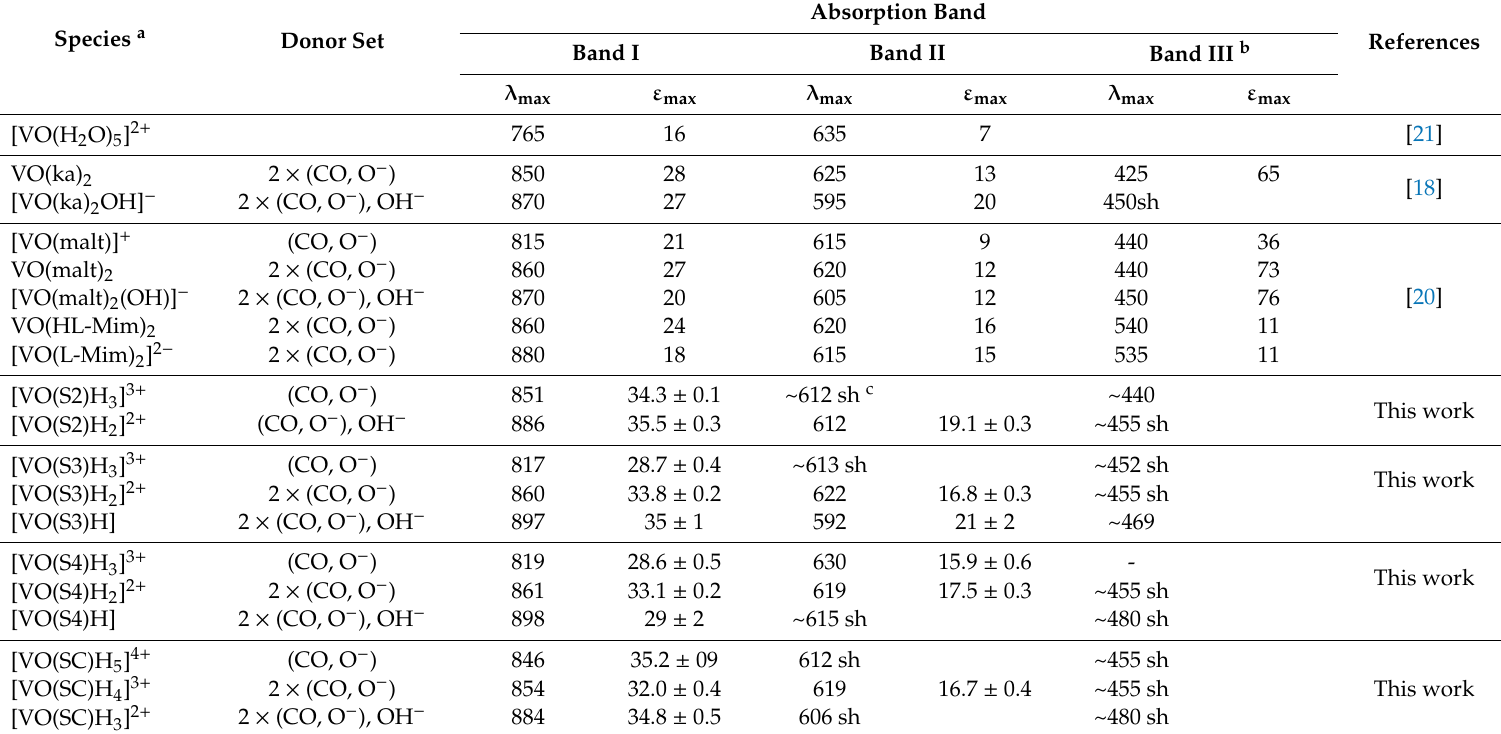
Table 2. Spectrophotometric parameters. Values of λ max (nm) and ε max (mol − 1 L cm − 1 ) of the species in